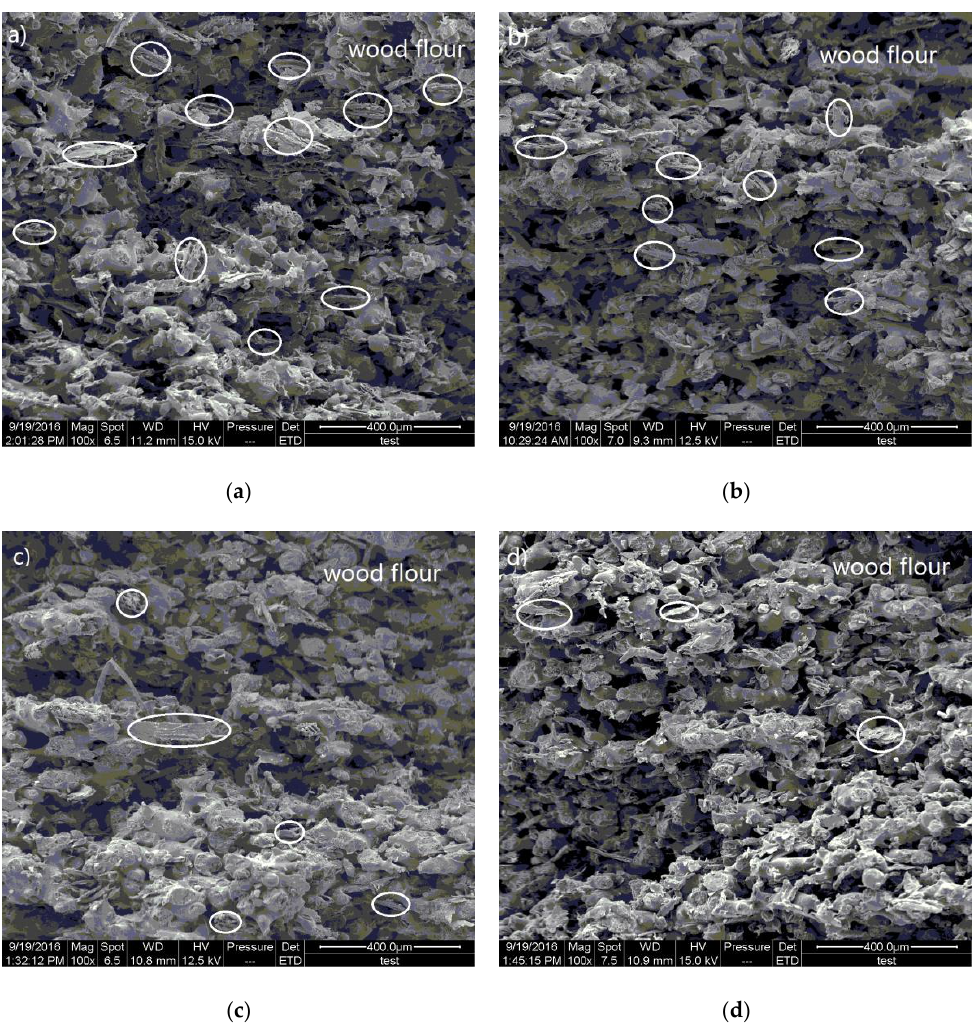
Figure 6. Lower magnification SEM images of fracture surface of specimens via SLS with CNT concentrations of ( a ) 0%, ( b ) 0.05%, ( c ) 0.1%, and ( d ) 0.15%. concentrations of ( a ) 0%; ( b ) 0.05%; ( c ) 0.1%; and ( d )